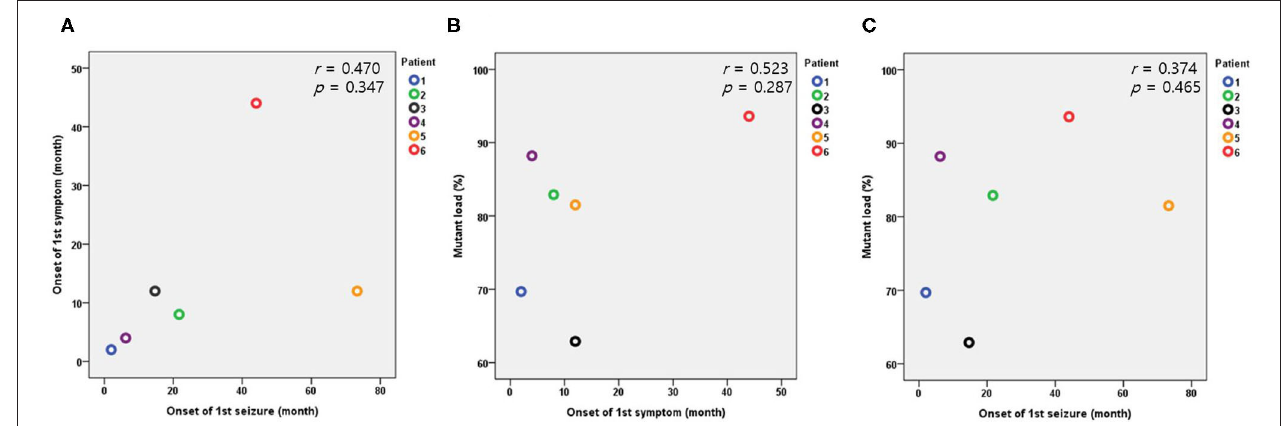
FIGURE 2 | Relationships between the onset of the first symptom, first seizure, and mutant load in the patients with the m.10191T > C mutation. (A) Relationship between the onset of the first symptom and first seizure. (B) Relationship between the onset of the first symptom and mutant load. (C) Relationship between the onset of the first seizure and mutant